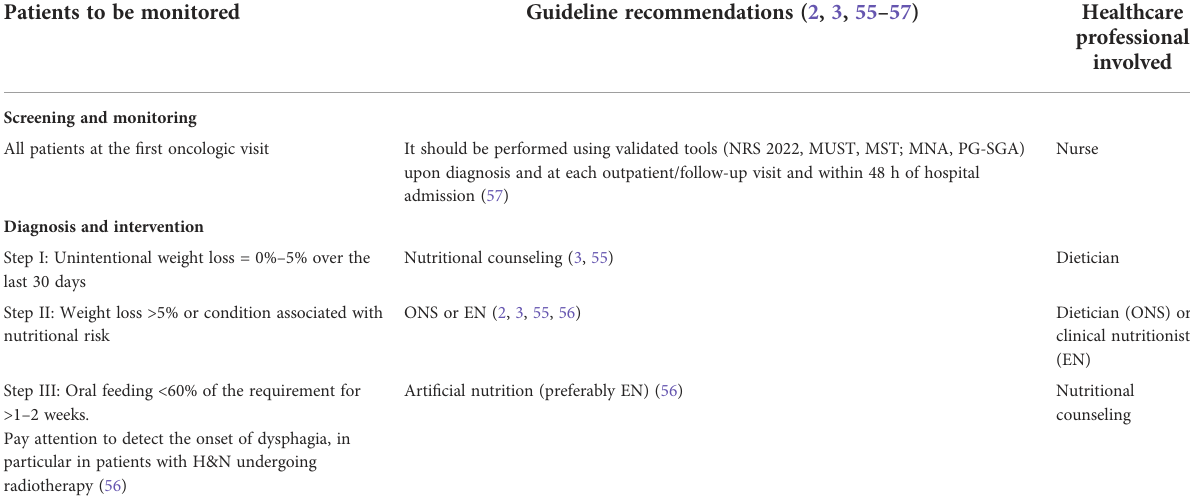
TABLE 1 Nutritional approaches recommended by guidelines and scienti fi c societies. Patients to be